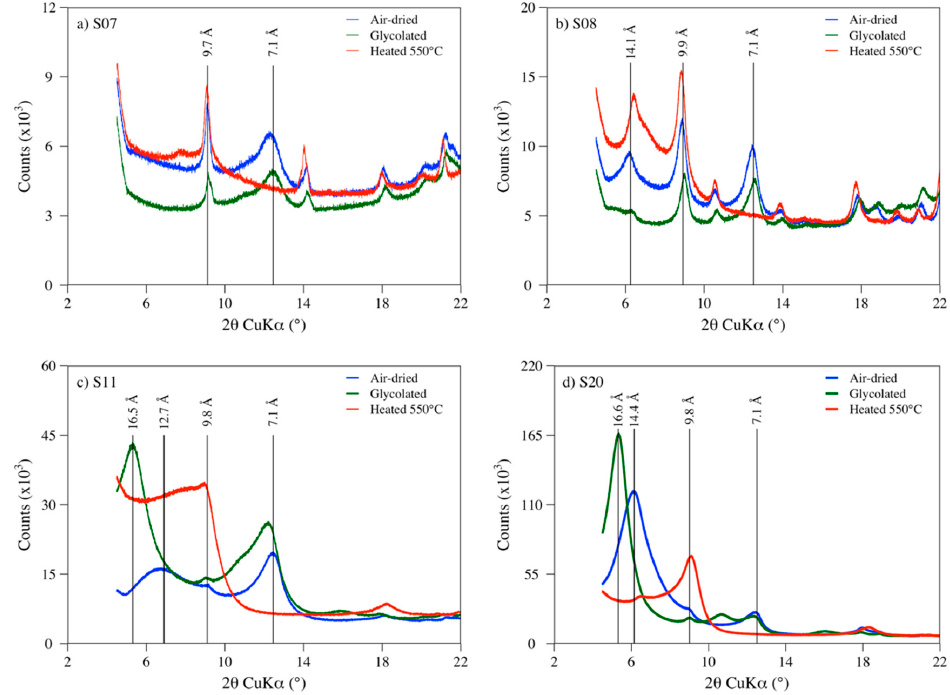
Figure 4. X-ray diffraction patterns of clay fraction of samples: ( a ) S07, ( b ) S08, ( c ) S11, and ( d ) S20.